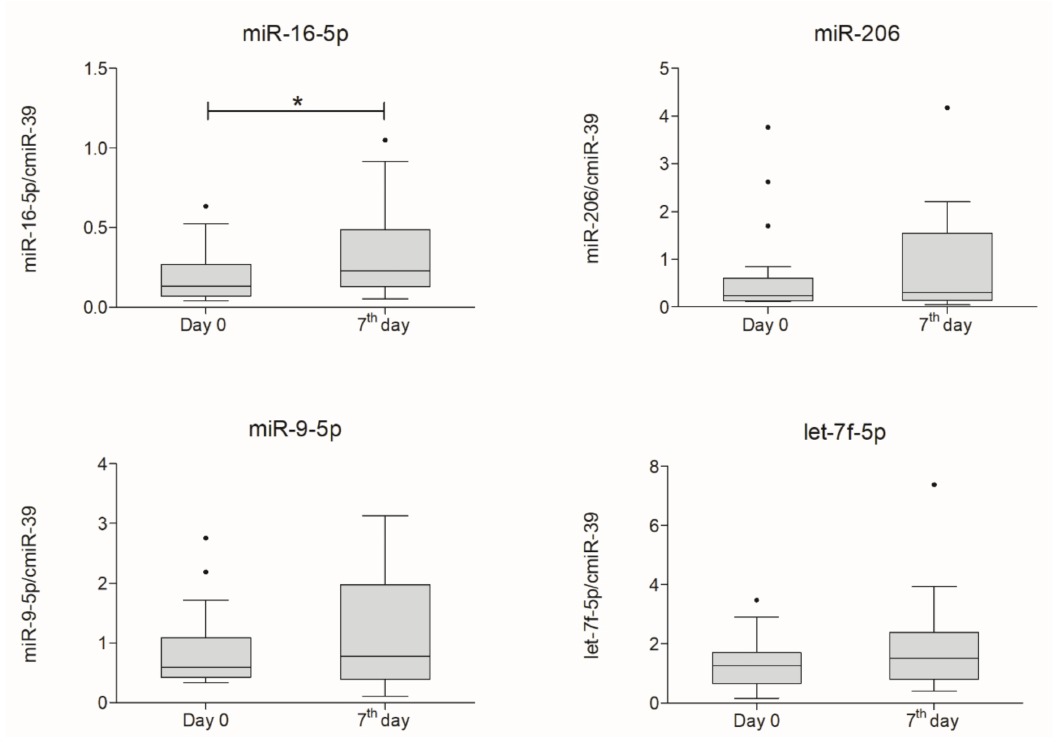
Figure 5. Boxplot representing plasma expression of analyzed miRNAs measured on day zero and a week after intrathecal lineage-negative cells application normalized to expression of synthetic cmiR-39 ( n = 18). Statistical analysis was performed using Wilcoxon signed-rank test. Whiskers range from 10th to 90th percentile. Horizontal line inside the box indicates the median. Level of significance-* p < 0.05.